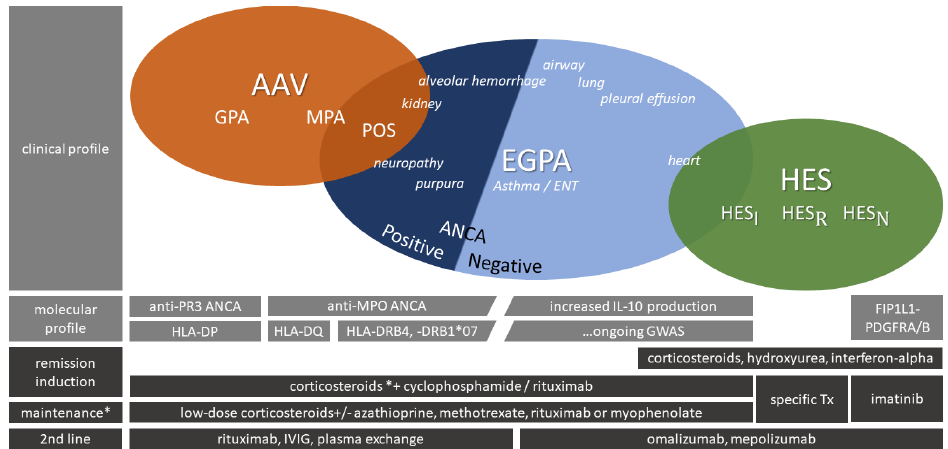
Figure 2. Eosinophil granulomatosis with polyangiitis (EPGA) and overlapping syndromes.